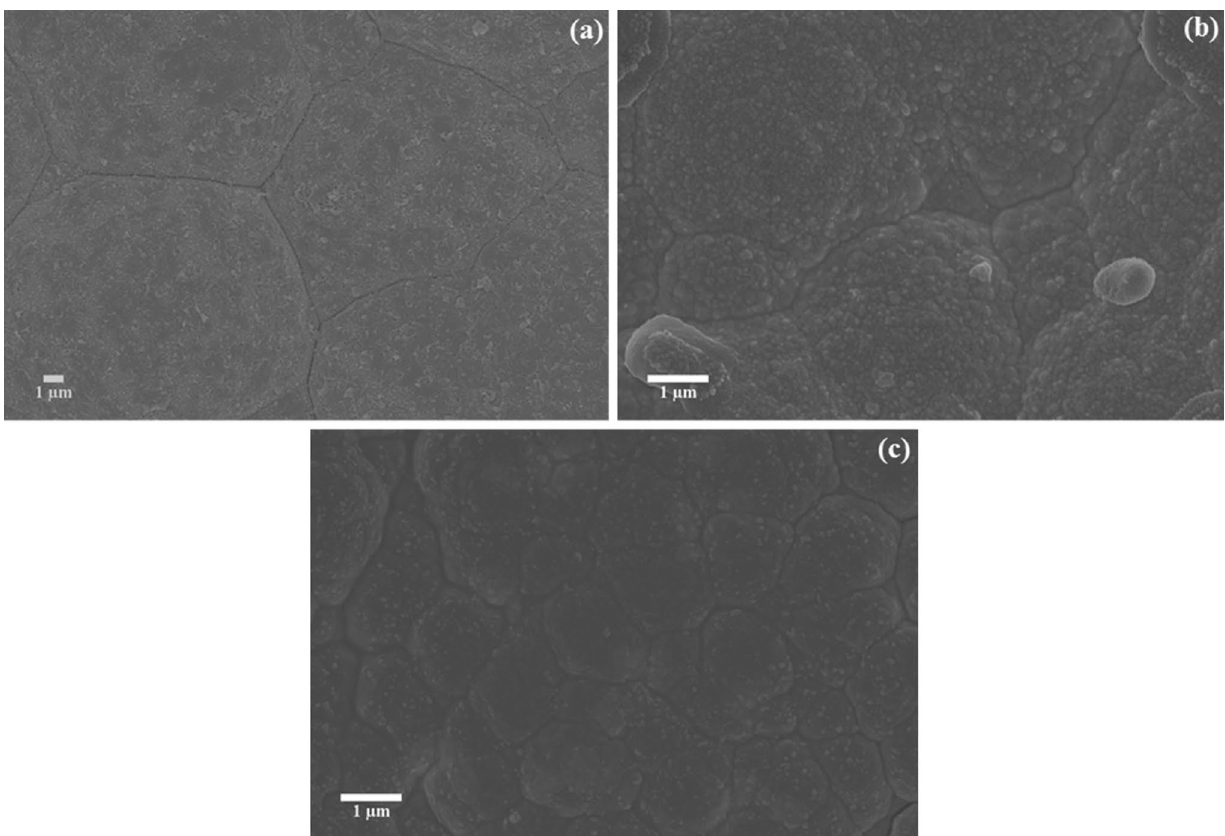
Fig. 4 FESEM image of pulse-electrodeposited Ni–Cr–P alloy at a 10 °C (± 3 °C), b 15 °C (± 3 °C), and c 25 °C (± 3 °C); having constant pH